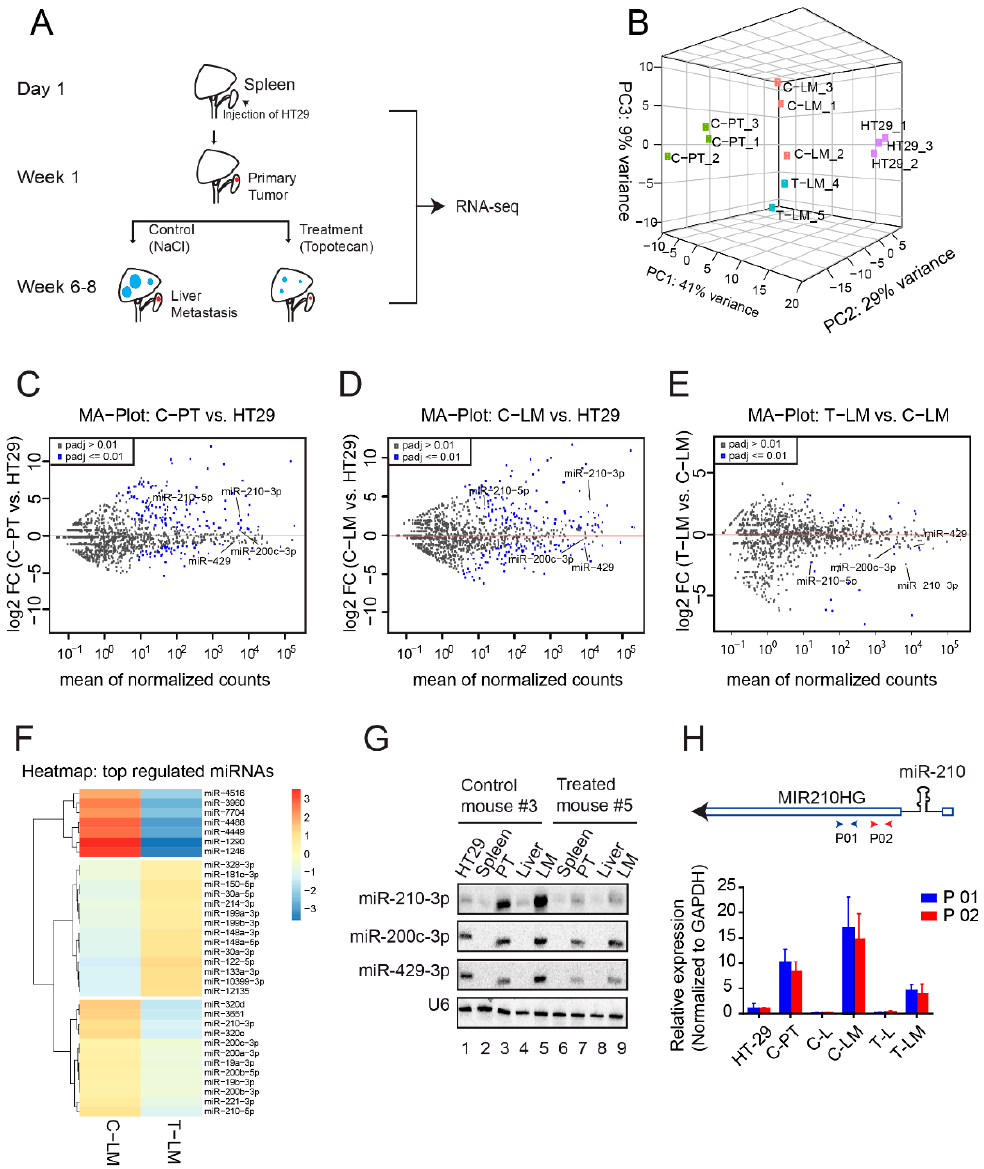
Figure 1 . Mouse model and identification of miRNAs and MIR210HG as targets of LDM topotecan chemotherapy. ( A ) Schematic overview of the RNA collection procedure for library preparation. HT29 was intrasplenically injected into six weeks-aged female severe combined immunodeficient (SCID) mice for development of primary tumors. After one week, treatment with LDM topotecan chemotherapy was initiated, while the control group received sodium chloride. All mice were sacrificed when bioluminescence levels reached about 500,000 photons/s (about six to eight weeks after injection). The primary tumors from the spleens of control mice (C-PT) and metastases from livers of control mice (C-LM) and treated mice (T-LM) were collected for RNA sequencing. RNA from HT29 cells was collected at the time of injection. ( B ) Principal component analysis of the samples from miRNA library. ( C – E ) Mean-log ratio (MA) plot of miRNA expression in primary tumors from control mice (C-PT) versus HT29, liver metastasis from control mice (C-LM) versus HT29, and liver metastases from treated mice (T-LM) versus liver metastases from control mice (C-LM), respectively. ( F ) Heatmap of differentially expressed miRNAs in liver metastases from treated mice (T-LM) versus liver metastases from control mice (C-LM). ( G ) Northern blot validation of differentially expressed miRNAs, including miR-210-3p, miR-200c-3p, miR-429. U6 serves as loading control. PT (primary tumors), LM (liver metastasis). ( H ) Upper panel: Schematic representation of miR-210 and its host gene MIR210HG . P01 and P02 represents different oligoes for the detection of MIR210HG by qPCR. Lower panel: qPCR validation of MIR210HG using two different oligoes. C-PT: primary tumors from control mouse, C-L: liver from control mouse, C-LM: liver metastasis from control mouse, T-L: liver from LDM topotecan treated mouse, T-LM: liver metastasis from LDM topotecan treated